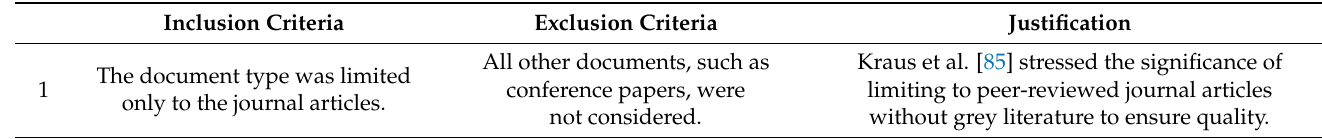
Table 2. Inclusion and exclusion criteria.